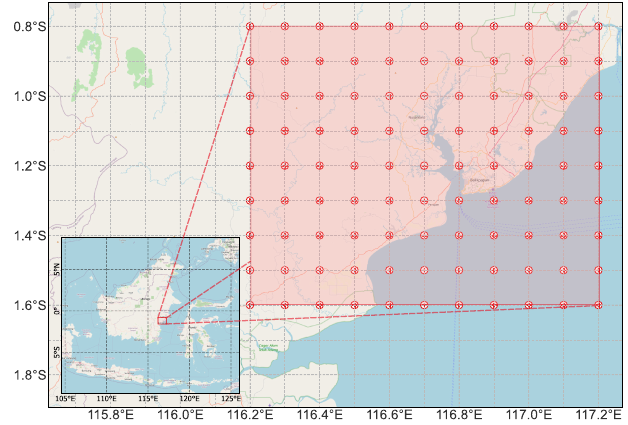
Figure 2. Release points of the moisture trajectories (from 116.2 ◦ –117.2 ◦ E and 0.8 ◦ –1.6 ◦ S, with an interval of 0.1 ◦ ). The vertical resolution is 500 m, extending from 500 to 5500 m above the ground level (m